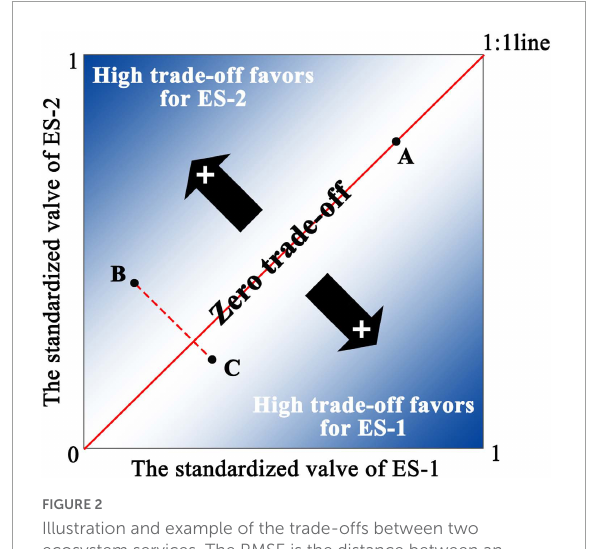
FIGURE2 Illustration and example of the trade-offs between two ecosystem services. The RMSE is the distance between an ecosystem service pair’s coordinates and line 1:1, where the two ecosystem services are equal. Take Figure 2 as an example, the trade-off value at point A is 0; the trade-off value at point B is higher than that at C. Moreover, at point B the trade-off favors ES2, but at point C the trade-off favors ES1. The graph was revised based on previous studies (Bradford and D’Amato, 2012; Lu et al.,